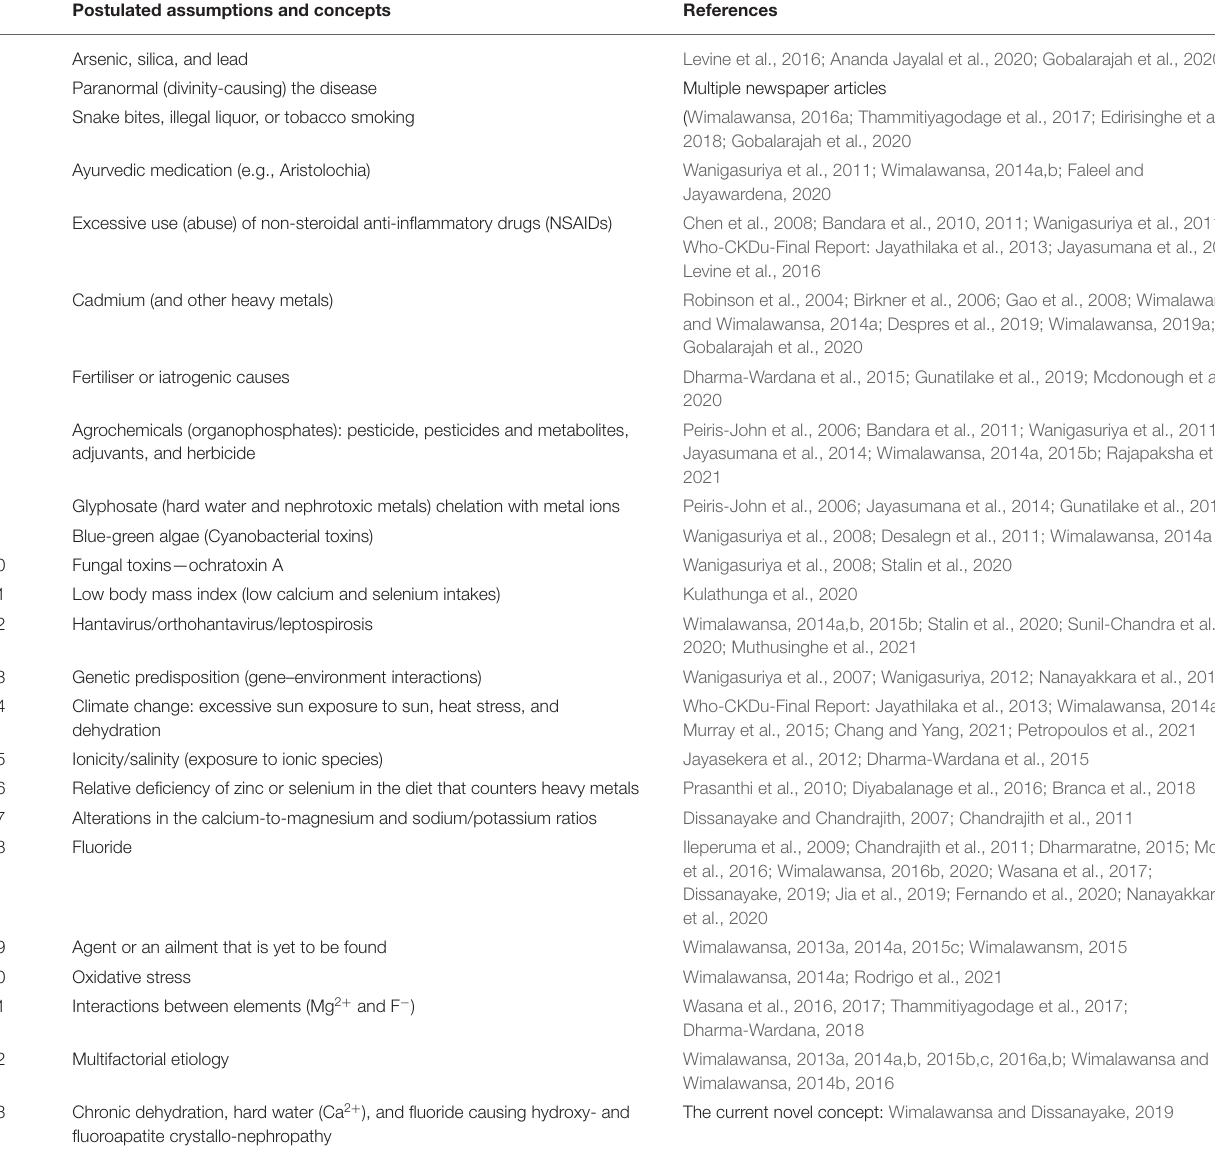
TABLE 3 | A summary of proposed theories for the causation of CKDmfo. Postulated assumptions and